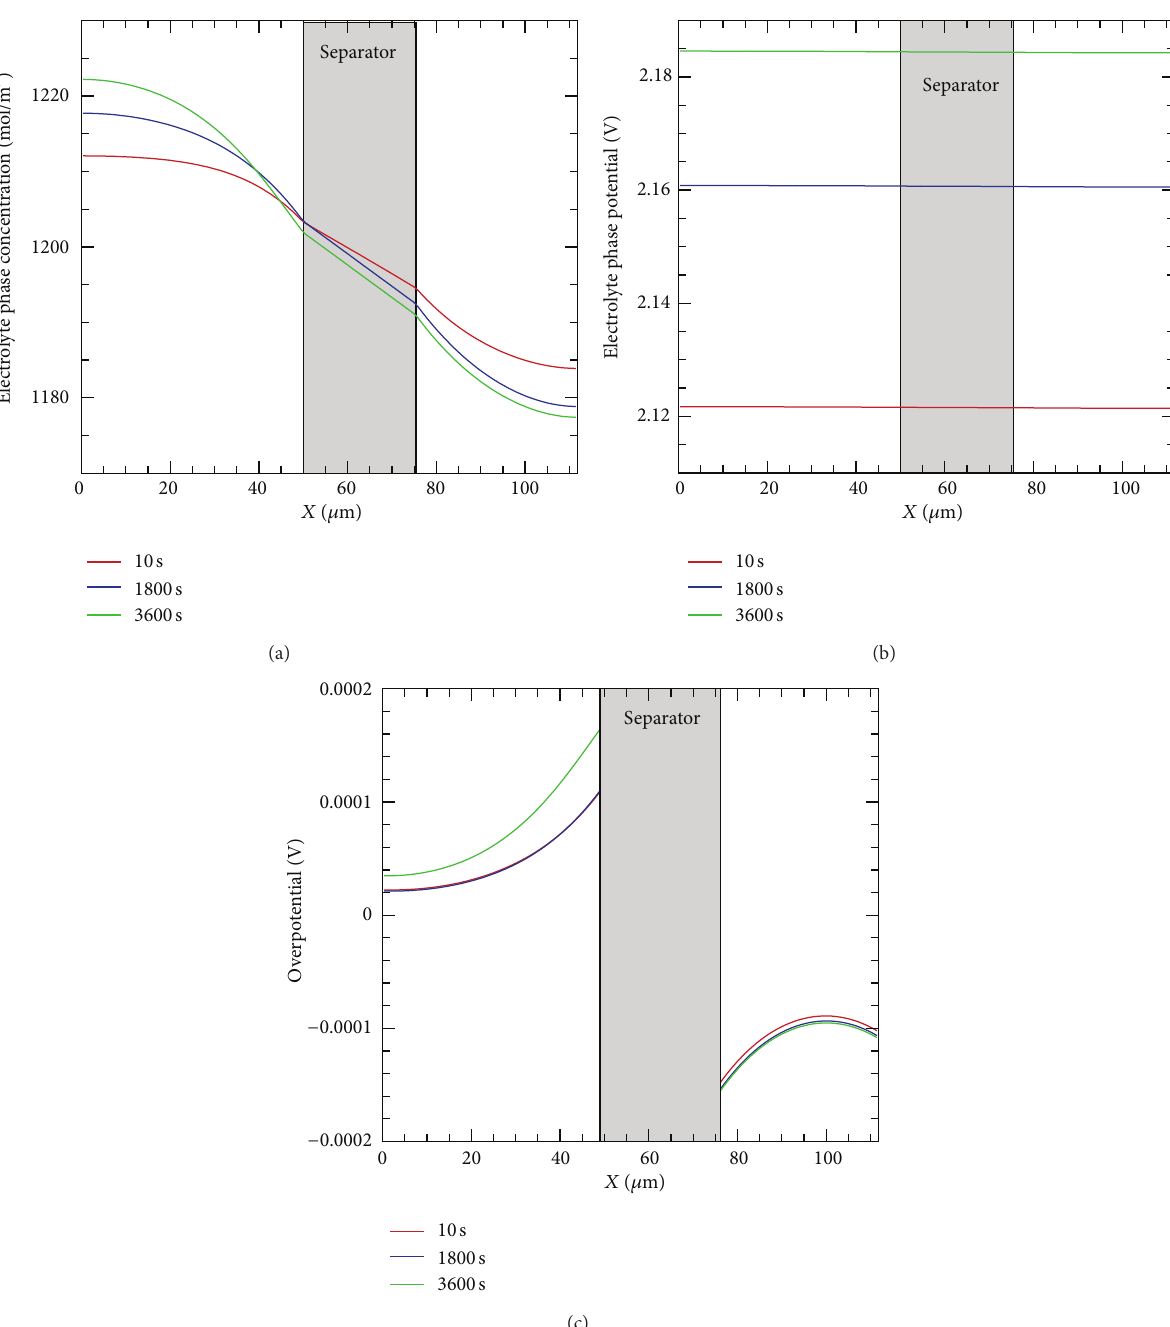
Figure 5: Spatiotemporal evolution of key quantities during the beginning, middle and end of the discharge process with 1C rate of discharge: (a) electrolyte phase concentration, (b) electrolyte phase potential, and (c) overpotential. ( R 1) is endothermic, while reaction ( R 2) is exothermic. the inclusion of the energy equation. Prior to performing the simulation, however, the thermal properties of the materials had to be estimated. Table 2 already shows the thermal properties used for the simulations. These were extracted from Srinivasan and Wang [3]. These authors also provided curve-fits for the rate of change of the open circuit potential with temperature (as appearing in (10)) for both Li 𝑥 C 6 and Li 𝑦 Mn 2 O 4 electrodes. During a discharge cycle, reaction